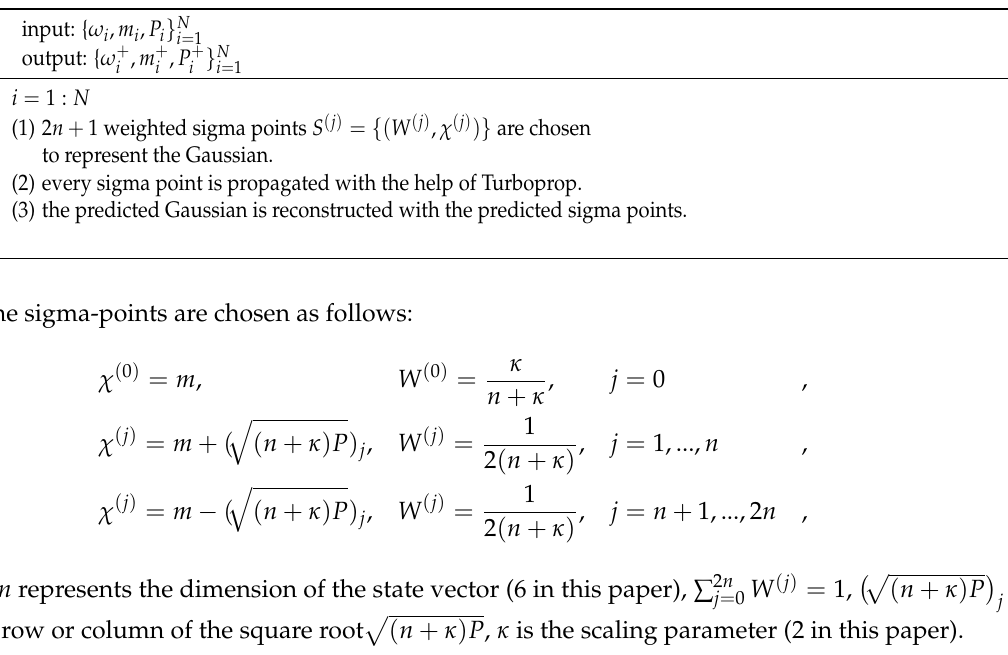
Table 1. State propagation of space